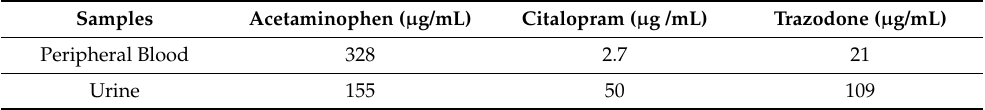
Table 2. Analytical results in biological matrices.